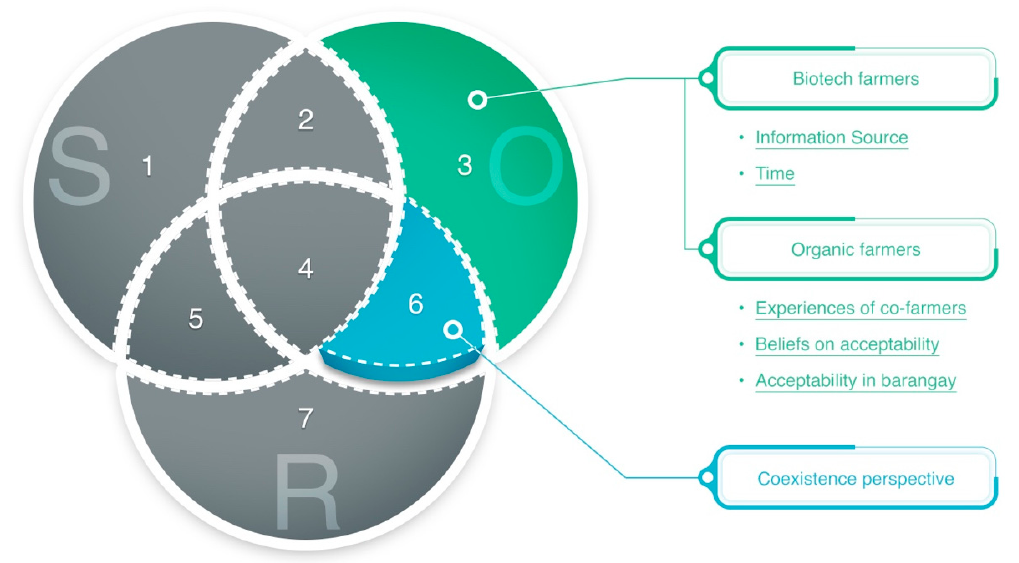
Figure 5. Stimulus–Organism–Response Model showing the influential factors affecting biotech and organic farmers’ coexistence perspective.